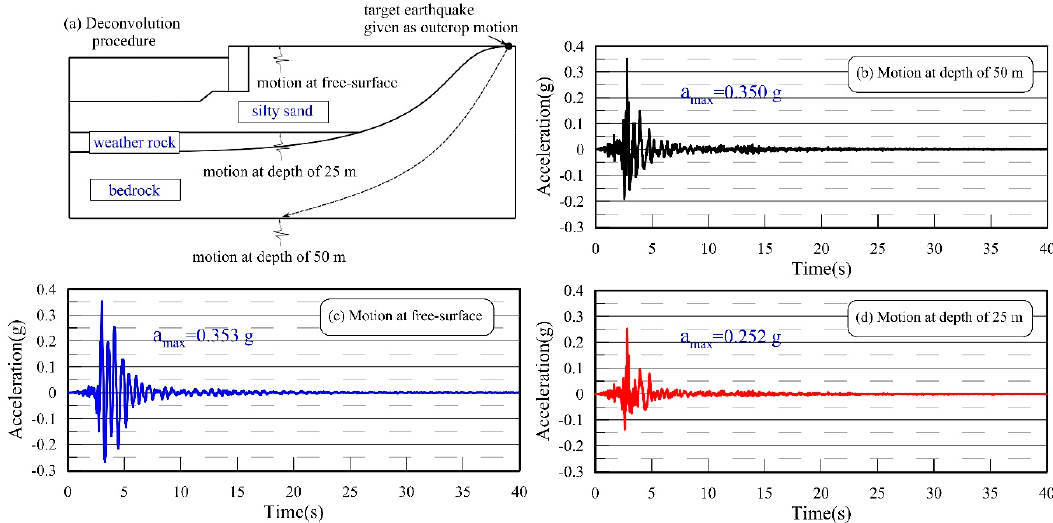
Figure 13. Extracted ground motions considering deconvolution procedure at Youngil-man port conducted in PROSHAKE: (a) locations of the extracted motions, (b) motion at depth of 50 m, (c) motion at free-surface, and (c) motion at a depth of 25 m.